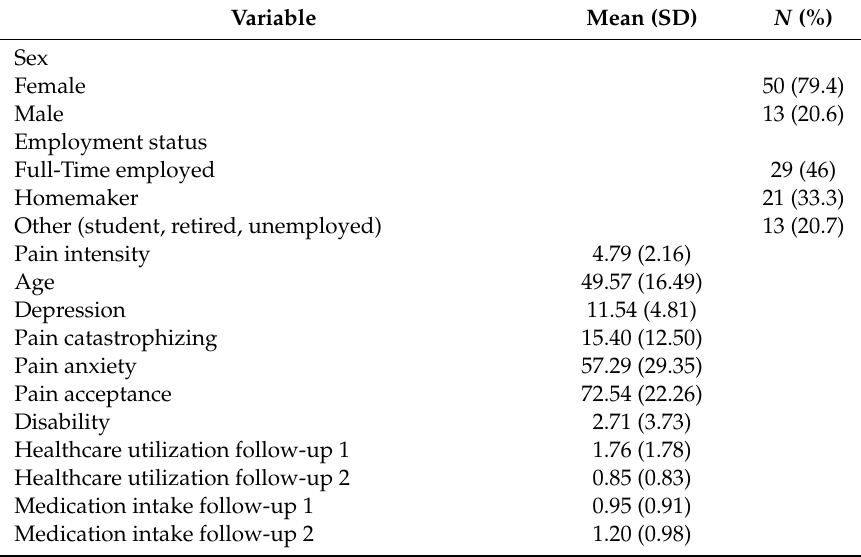
Table 1. Means and percentages of the predictive and outcome variables.